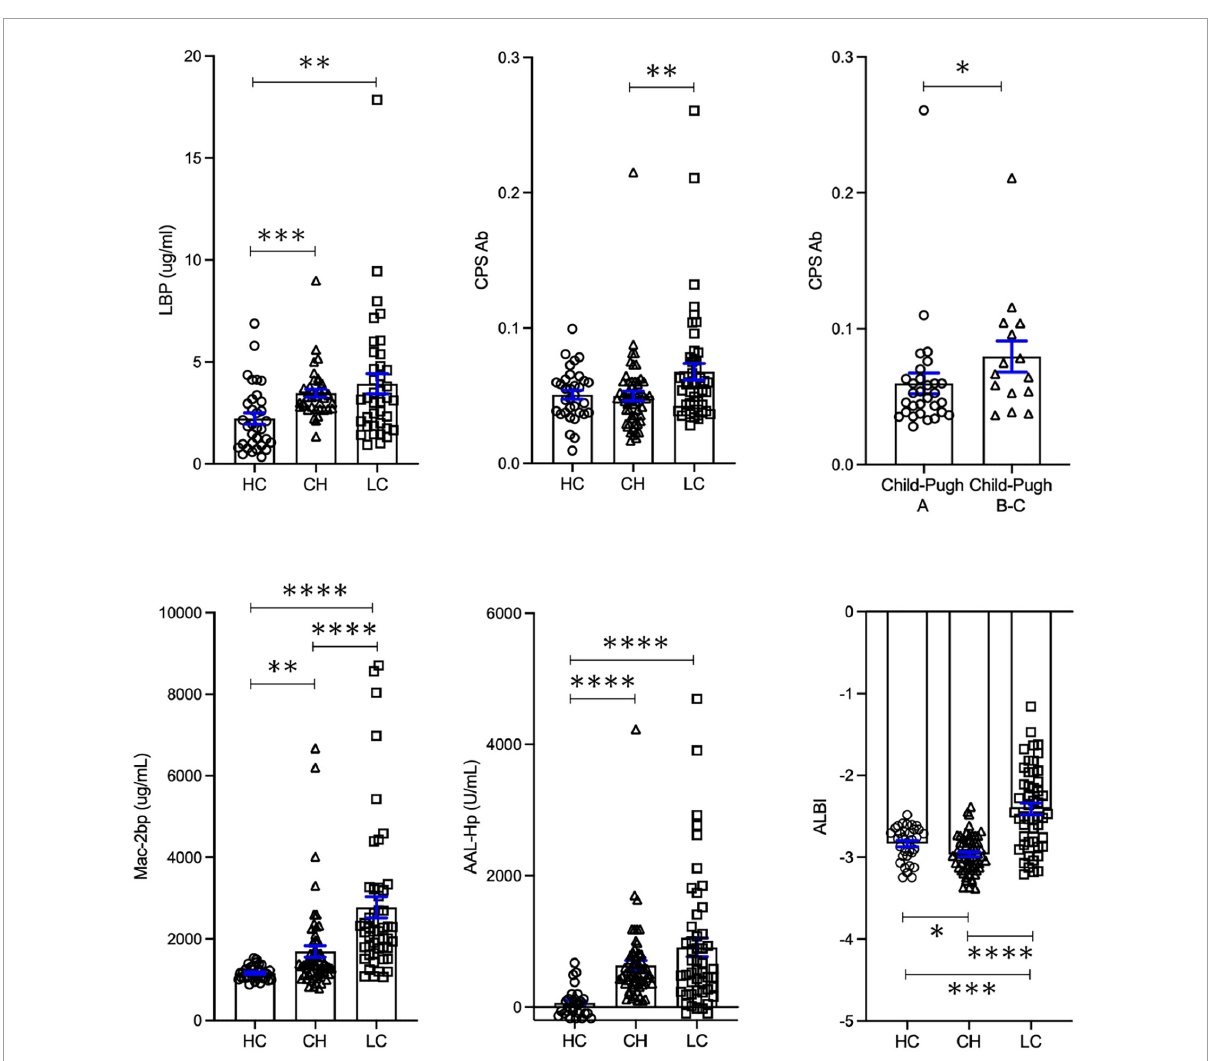
FIGURE1 Serum biomarker levels in healthy controls, chronic hepatitis and liver cirrhosis groups. Changes in LBP, E. CPS, Mac-2 bp, AAL-Hp and ALBI. HC, healthy controls; CH, chronic hepatitis; LC, liver cirrhosis; LBP, lipopolysaccharide-binding protein; E. CPS, E. faecalis capsular polysaccharide; Mac-2 bp, Mac-2 binding protein; AAL-Hp, Aleuria aurantia lectin-haptoglobin; ALBI, albumin-bilirubin. ∗ p < 0.05, ∗∗ p < 0.01, ∗∗∗ p < 0.001, ∗∗∗∗ p <